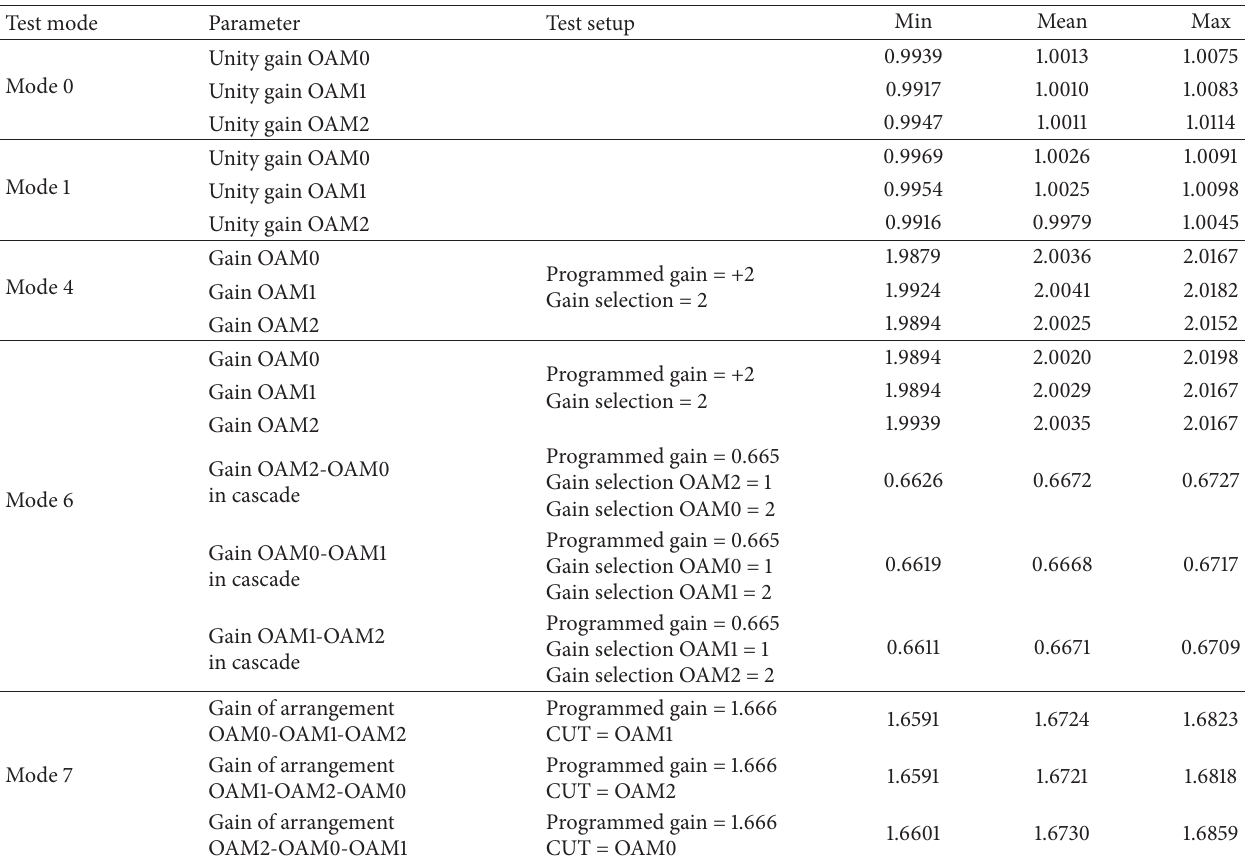
Table 5: Modes test experimental results.